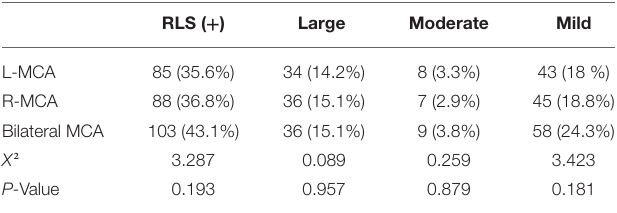
TABLE 2 | Positive results of LMC, RMCA, bilateral MCA and shunt degree statistics.